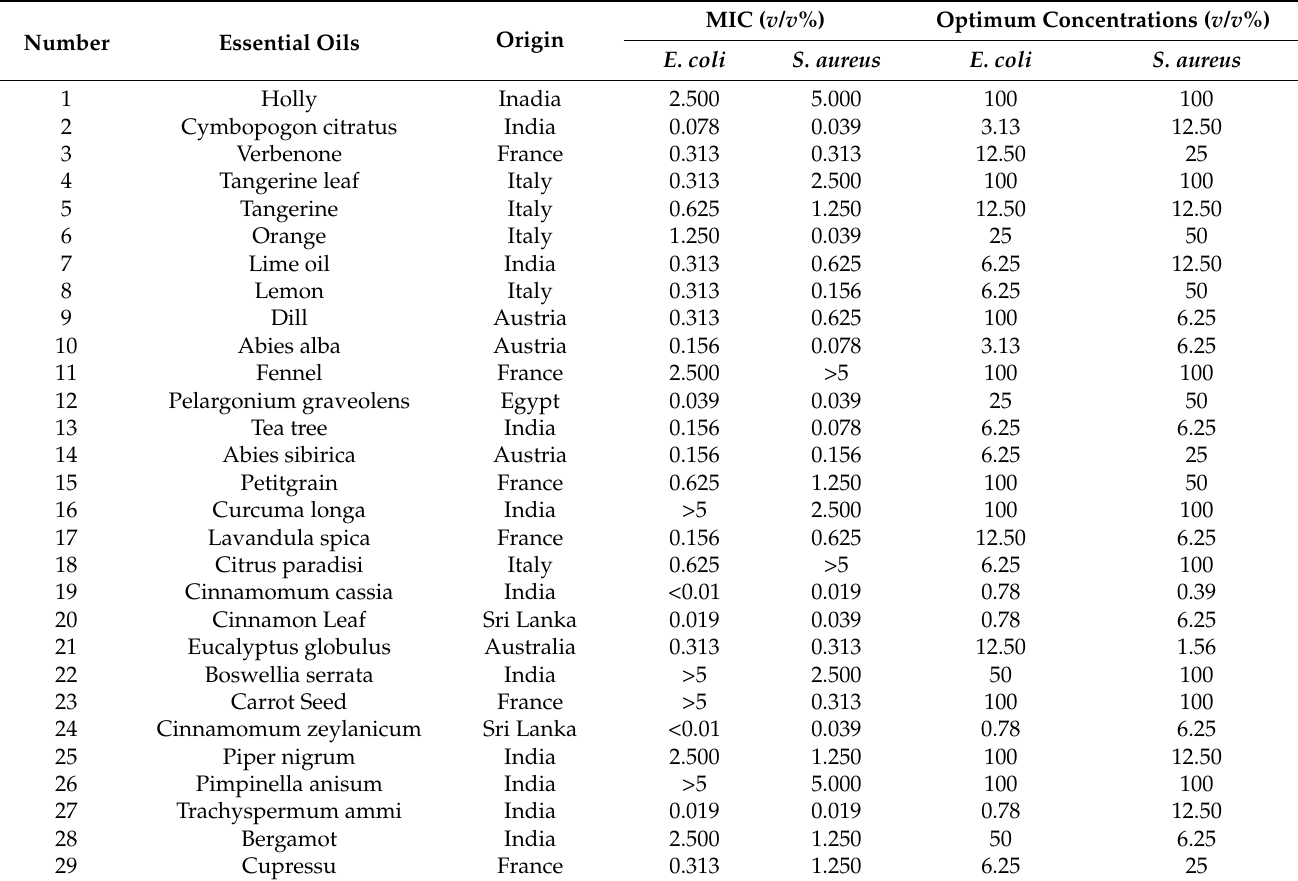
Table 1. Origin of essential oils and MIC values and optimum concentrations against E. coli ATCC 25922 and MRSA 43300.